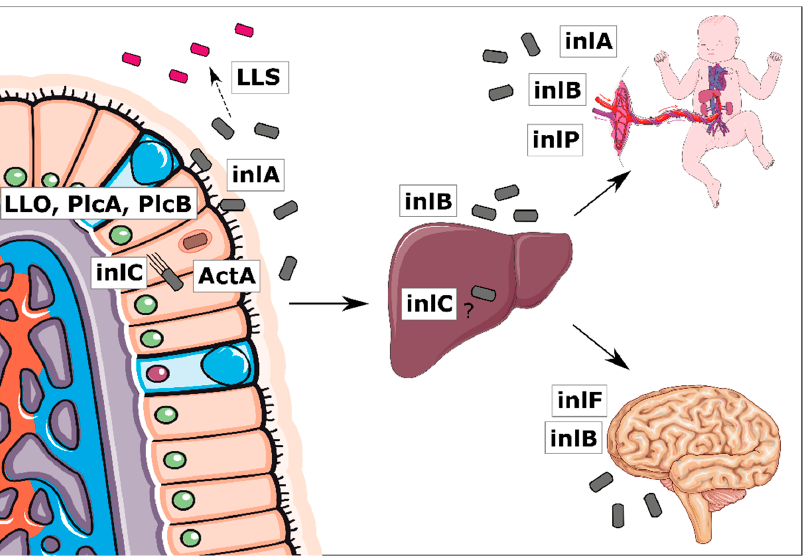
Figure 1. Scheme of L. monocytogenes infection including the studied virulence factors [11,14].